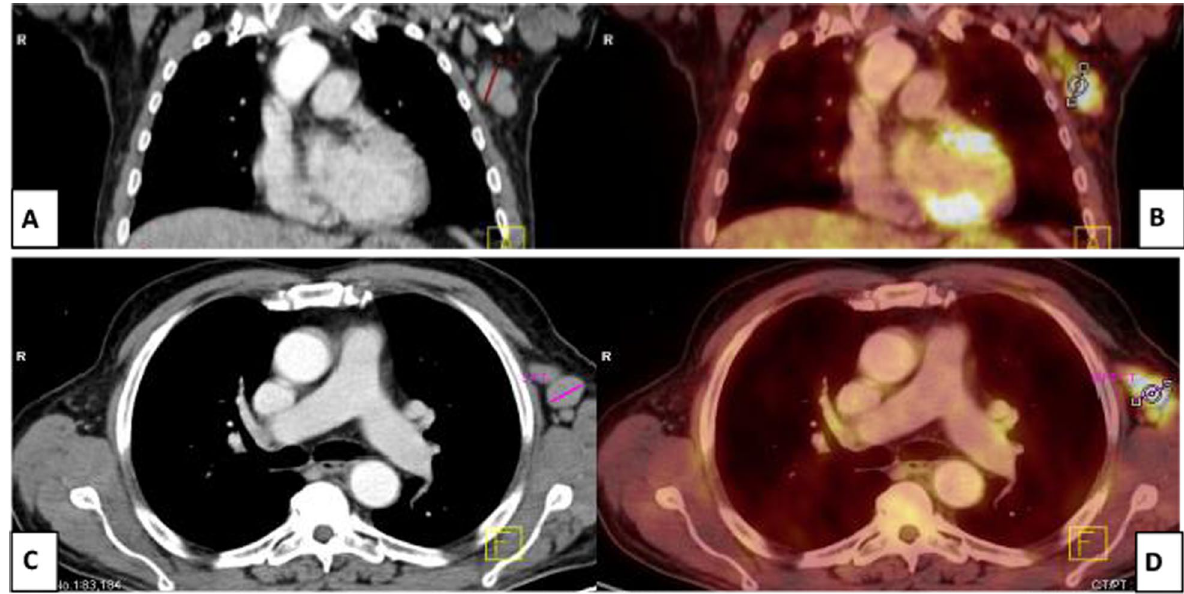
Fig. 2 A 54-year-old male patient with Hodgkin’s lymphoma, treated with anti-cd20 antibody rituximab 4 months prior to vaccination. A Coronal and C axial CECT images revealed multiple enlarged left axillary LNs, largest measures 2.7 cm. B Coronal and D axial PET-CT images revealed enlarged and FDG-avid left axillary LNs of 3 SUVmax. At first, this was diagnosed as progression, ultrasound-guided biopsy-revealed reactive follicular hyperplasia with no malignancy. Clinical history revealed that he got the 2nd dose of Pfizer-BioNTech COVID-19 vaccine in his left arm